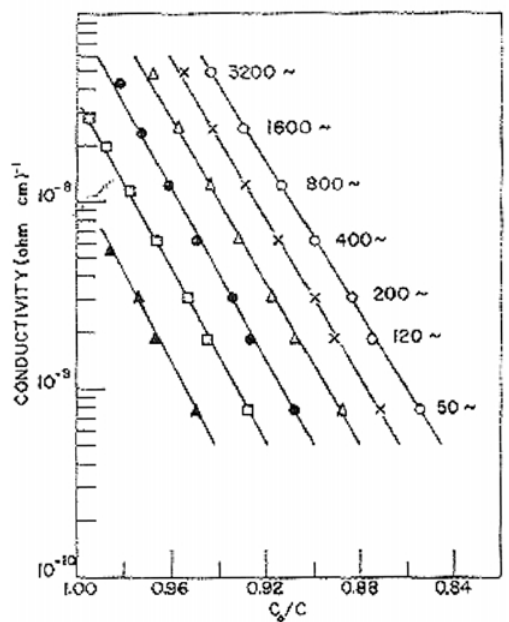
FIGURE 2a Distribution of conductivity in heat-treated, anodized tantalum at several temperatures (75V anodization, heated 30min at 400 (cid:4) , in air). s , 30 (cid:4) ; (cid:3) , 20 (cid:4) ; D , 10 (cid:4) ;